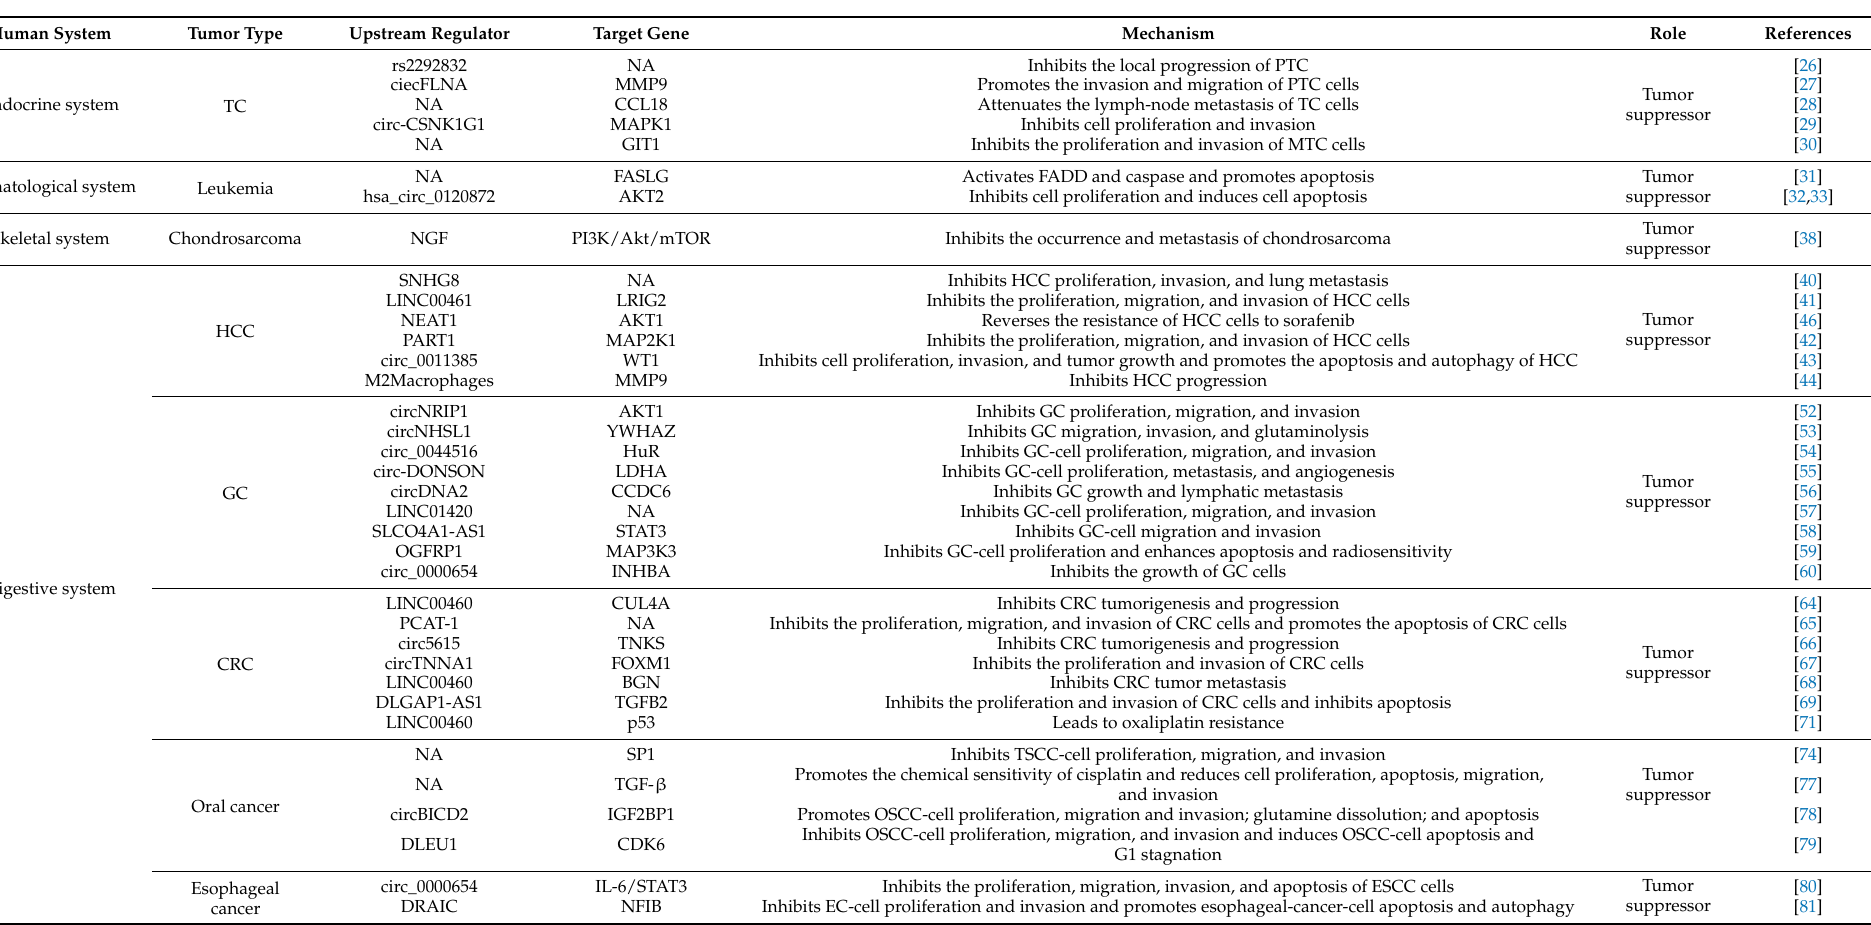
Table 1. Roles of miR-149-5p in different human